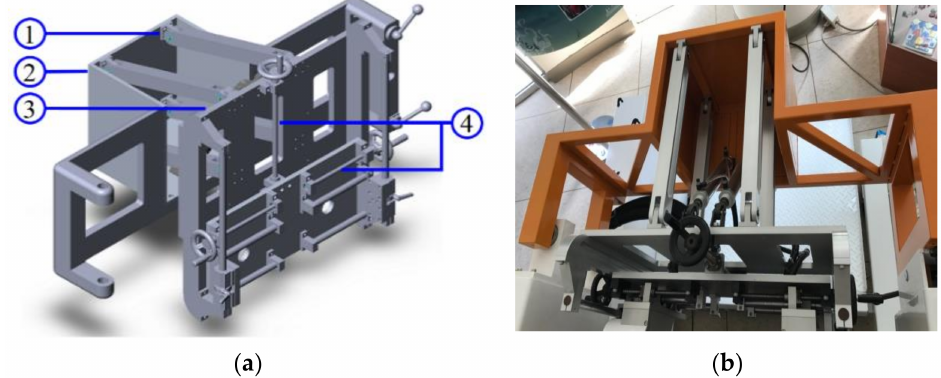
Figure 4. ( a ) The design of the pneumatic postural support system; ( b ) picture of the pneumatic postural support system. 1 (cid:13) Hinge, 2 (cid:13) Back frame of revolving door, 3 (cid:13) Pneumatic cylinder, 4 (cid:13) Lead screw.